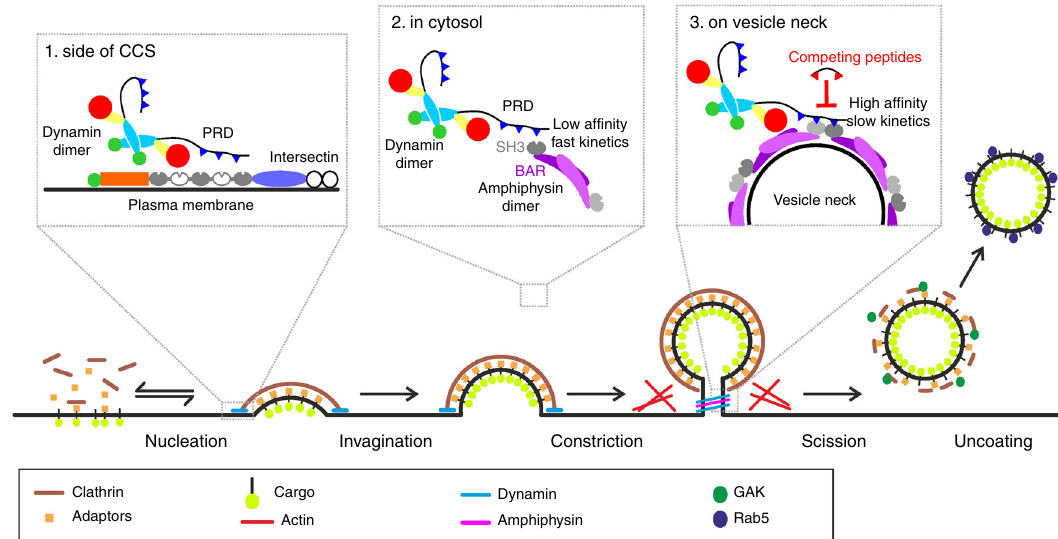
Fig. 6 Model of dynamin recruitment to forming CCVs. Model of dynamin recruitment by its PRD domain with SH3 containing proteins. (1) At early stages of CCV formation dynamin interacts with intersectin which has multiple dynamin interacting (grey) and non-interacting (white) SH3 domains. (2) In the cytosol, dynamin forms a dimer, as well as SH3 domain containing proteins such as amphiphysin. The SH3 domains of the dimer are too far apart to stabilize the interaction with the PRD via multiple binding motifs. (3) On the vesicle neck, two dimers of amphiphysin are arranged such that two SH3 domains are next to each other. This ensures high af fi nity of dynamin with this con fi guration enabling the fast recruitment of